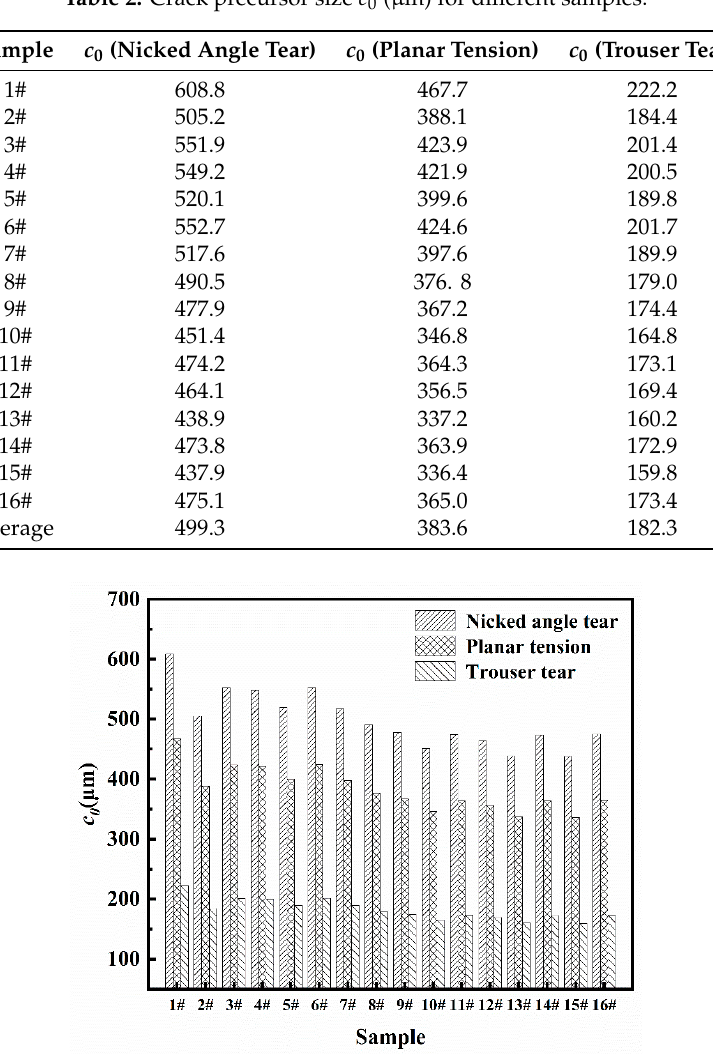
Figure 10. Crack precursor sizes of the different samples under different tear modes. Table 2. Crack precursor size c 0 ( μ m) for different samples.